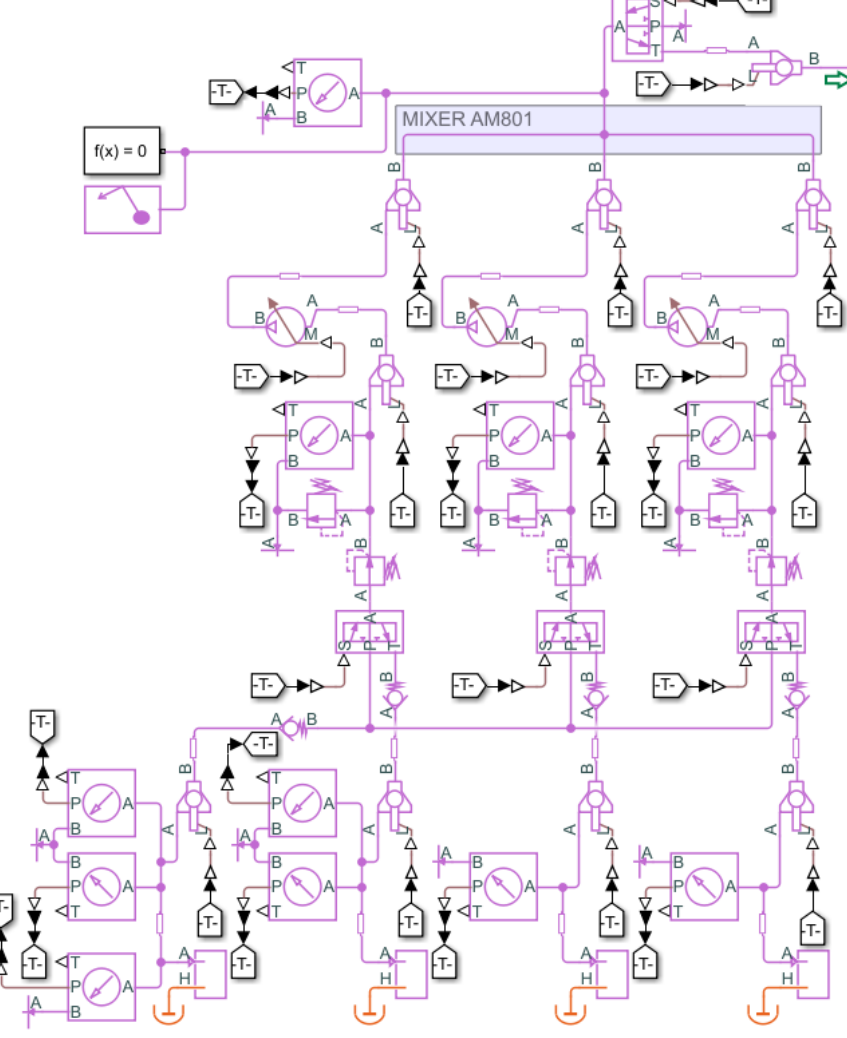
Figure 5. The simulation model of the mixer